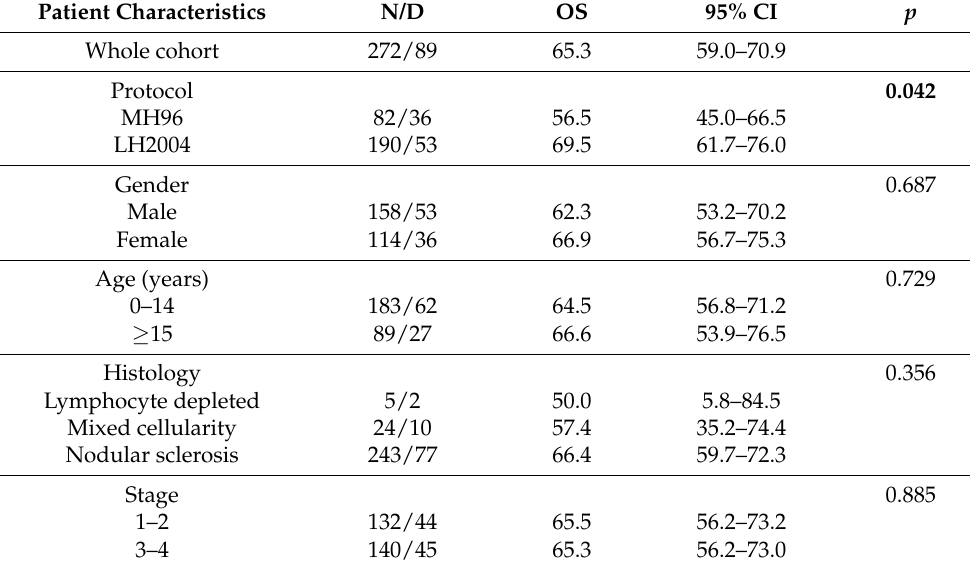
Table 5. Ten-year overall survival of 272 patients with classical Hodgkin’s lymphoma after recurrence by characteristics at diagnosis.